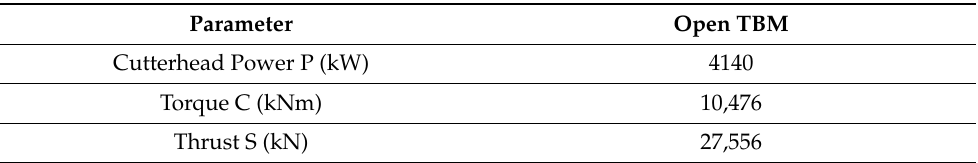
Table 8. Minimum values of P, C, and S with which open TBMs must work in rock formations with the presence of gneiss, having chosen a diameter of 11